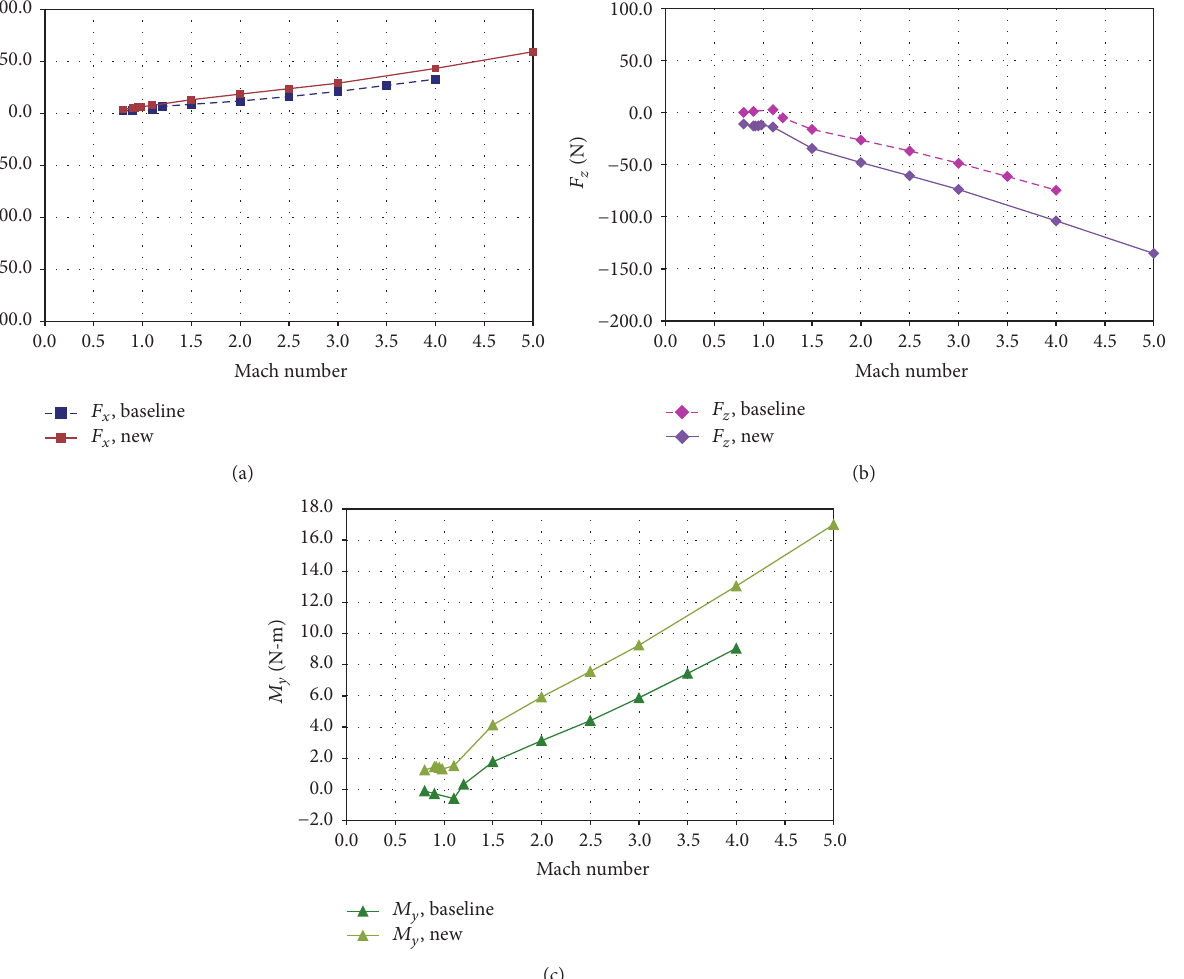
Figure 13: Comparison of delta forces and moment between the baseline and the optimized 8-flap configurations, 𝛼 = 0 ∘ : (a) delta axial force, (b) delta normal force, and (c) delta pitching